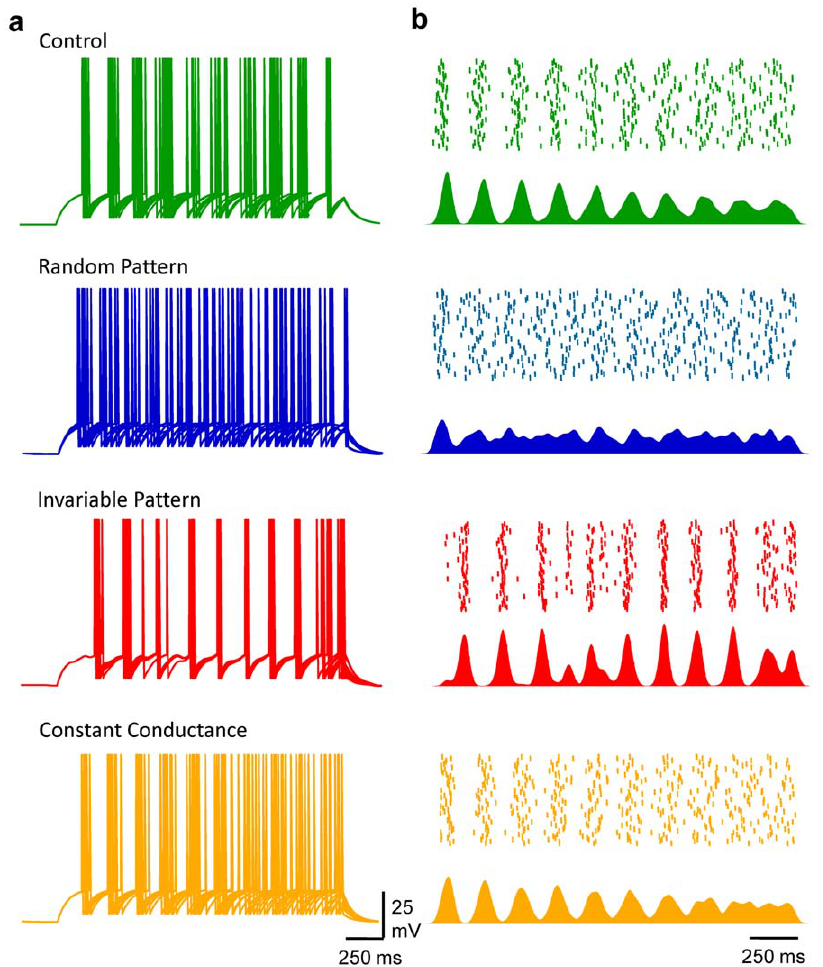
Figure 5. Randomly occurring GABA A conductance transients underlie the frequency-dependent tuning of pyramidal cell discharge fidelity. a, Superimposed (10) Vm fluctuations of the LIF model in response to a DC step (2 s) that allows a firing rate of 5 spikes/s, in control conditions (green, 95 pA), when the LIF model received 33 randomly occurring GABA A events/s (blue, 111 pA), an invariable pattern of 33 GABA A events/s (red, 110 pA), or when the neuron model received a constant G GABA-A equivalent to the average conductance for a rate of 33 events/s (orange, 110 pA). b up, Raster plot of spike times collected from 50 consecutive trials in the various conditions depicted in a; down, Spike probability over time for these 50 consecutive